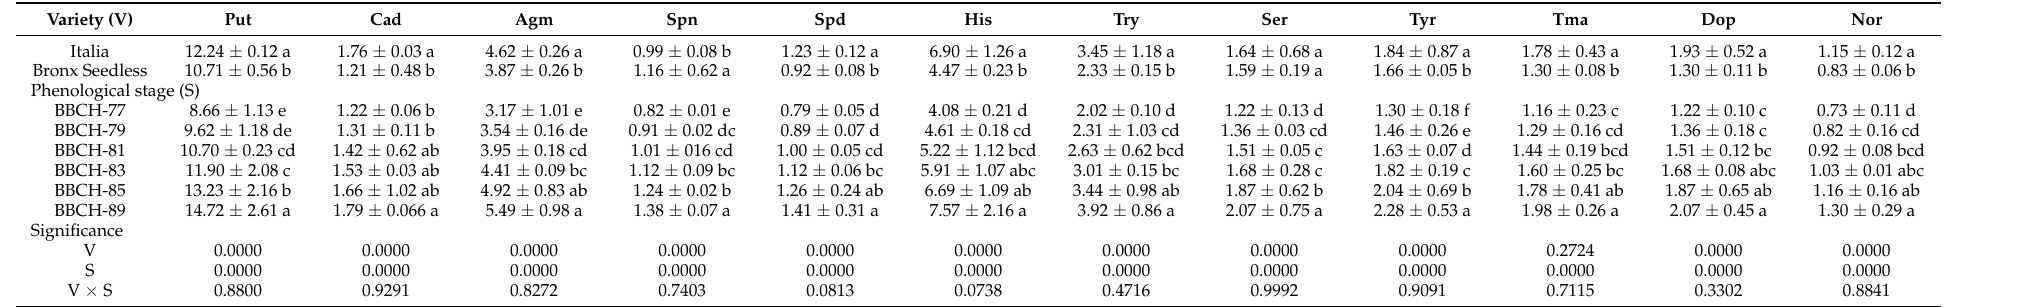
Table 1. Biogenic amines content ( µ g · L − 1 ) of Italia and Bronx Seedless table grapes harvested in six different phenological stages (BBCH-77, BBCH-79, BBCH-81, BBCH-83, BBCH-85, and